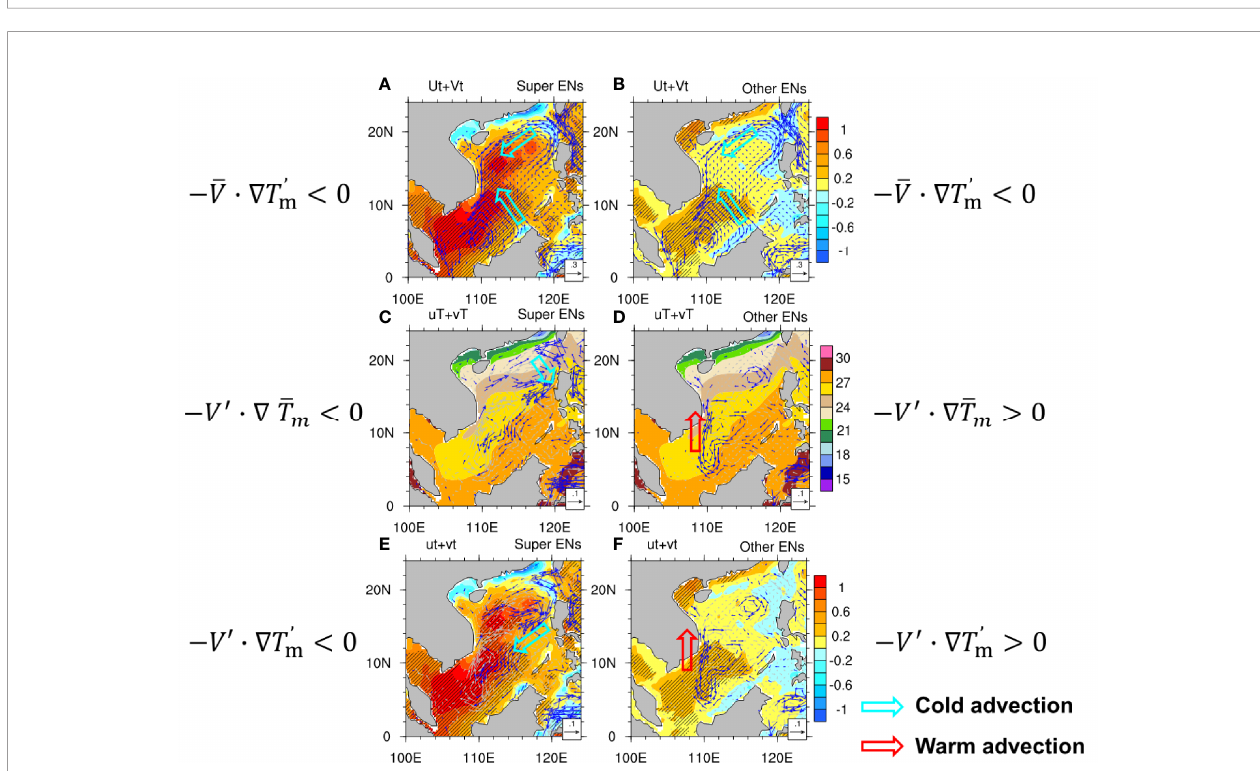
FIGURE 10 | (A) The SST anomalies (shading, unit: °C) and mean mixed layer averaged currents (vectors, unit: m/s) over Jan – Feb – Mar [JFM(+1)] for super El Niño composite. (B) Same as in (A) but for other El Niño composite. (C) Mean SST (shading) and mixed layer averaged current anomalies (vectors) over JFM(+1) for super El Niño composite. (D) Same as in (C) but for other El Niño composite. (E) The SST anomalies (shading) and mixed layer averaged current anomalies (vectors) over JFM(+1) for super El Niño composite. (F) Same as in (E) but for other El Niño composite. The composite SST and current results exceeding the 90% con fi dence level are hatched and shown in blue vectors based on Student ’ s t